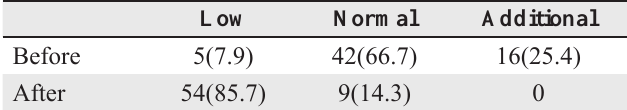
Table 5 : Amount of salt taken before and after the diagnosis of hypertension